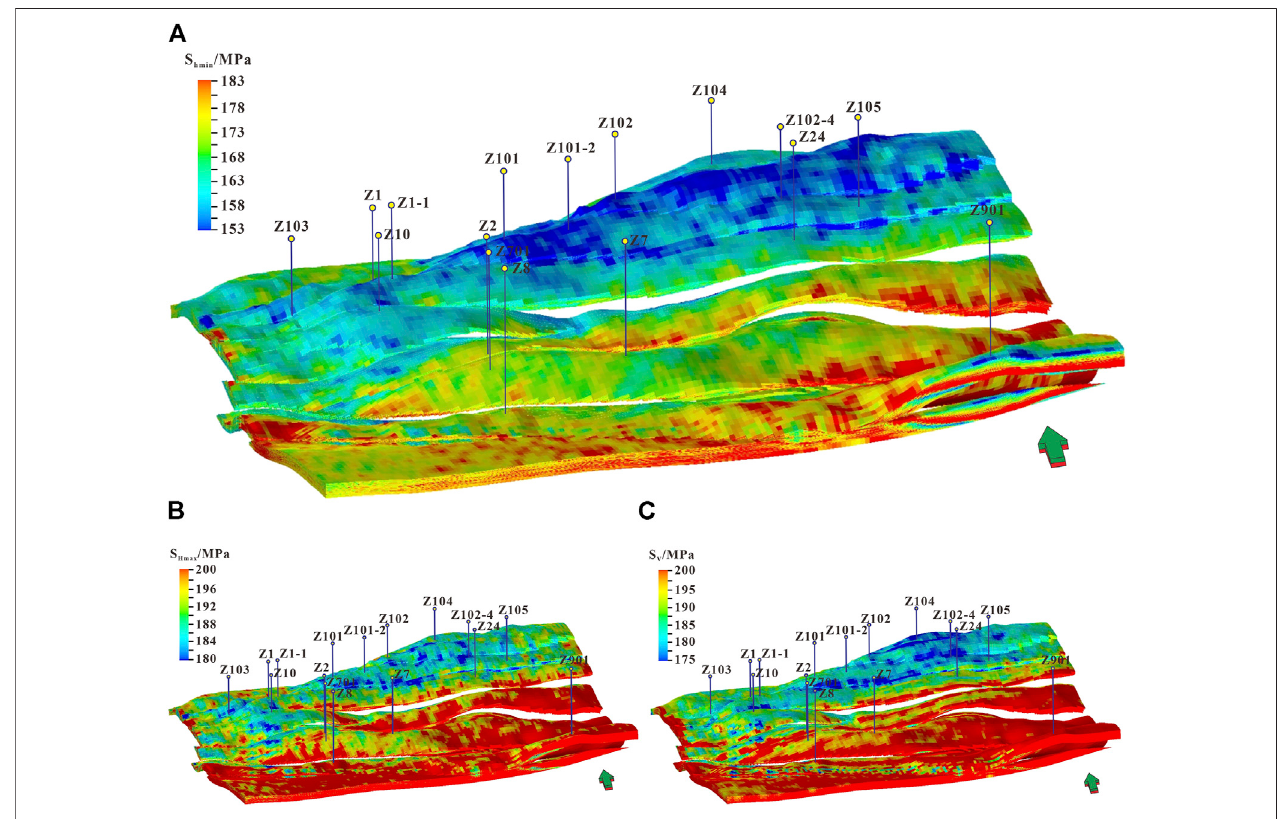
FIGURE 5 | 3D heterogenous in situ stress fi eld in the Bozi gas fi eld. (A) S h ; (B) S H ; and (C) S v .